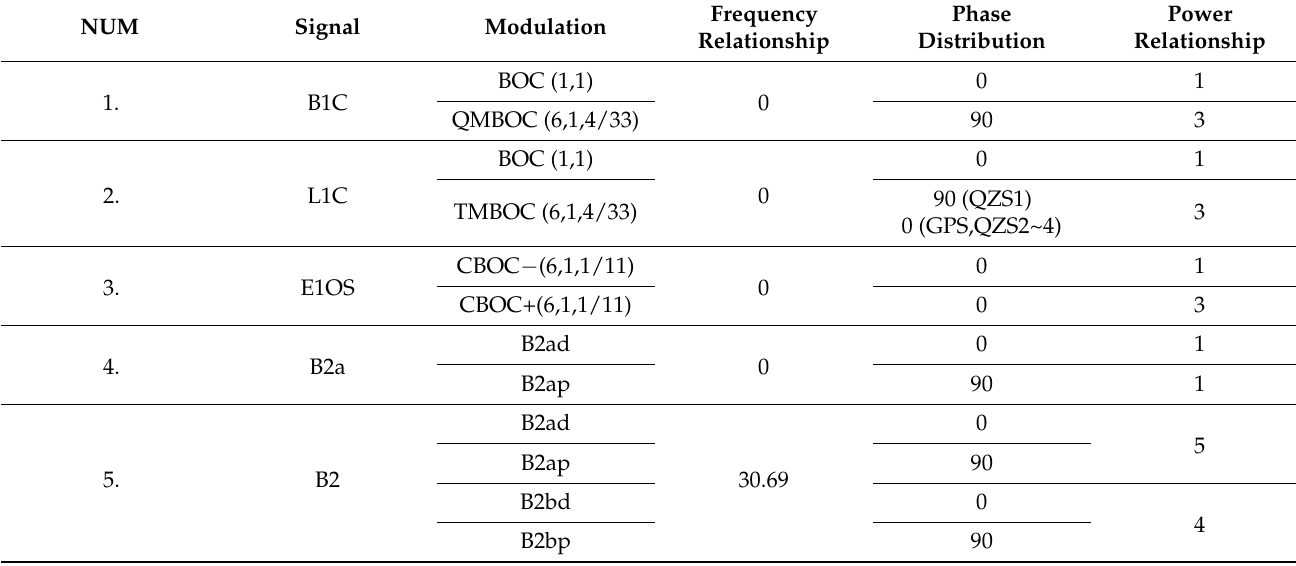
Table 2. Characteristics of the five representative signals.